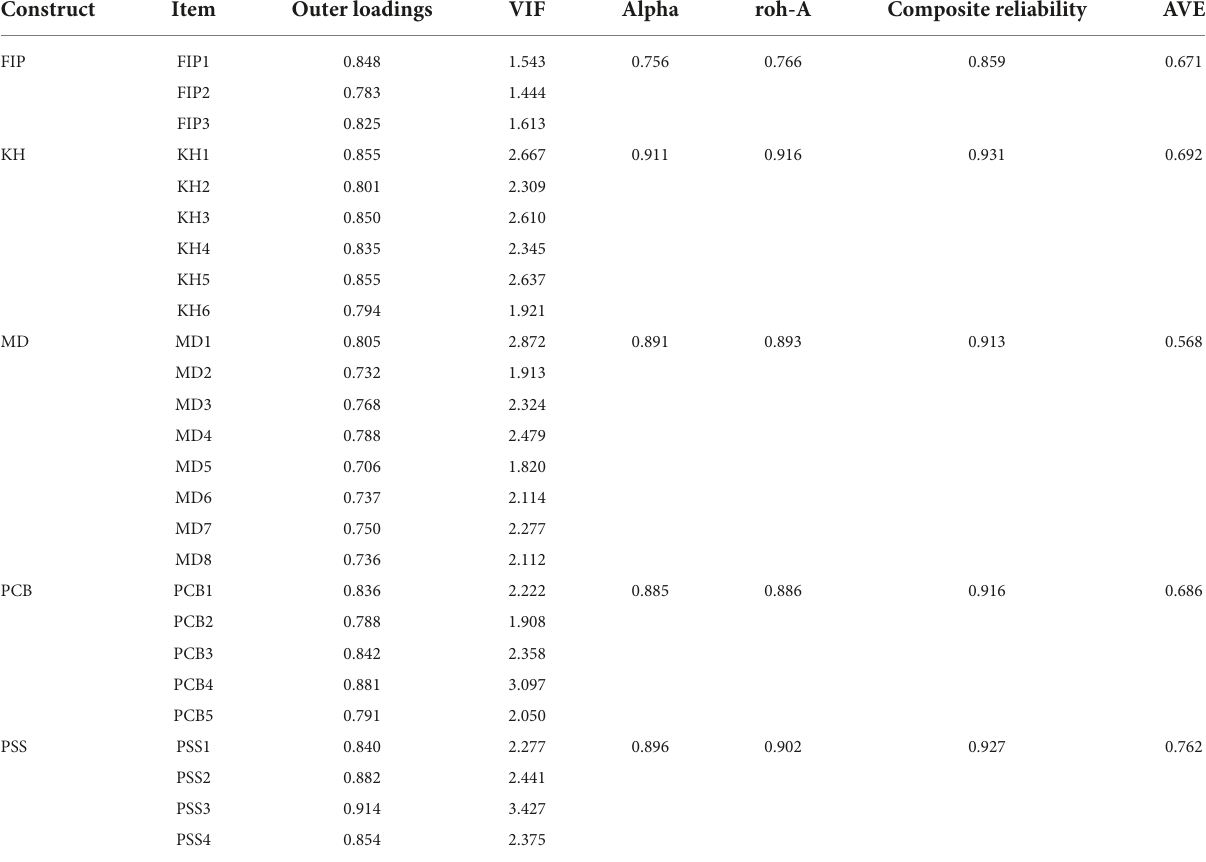
TABLE 6 Reliability and convergent validity of the study constructs (moderation).